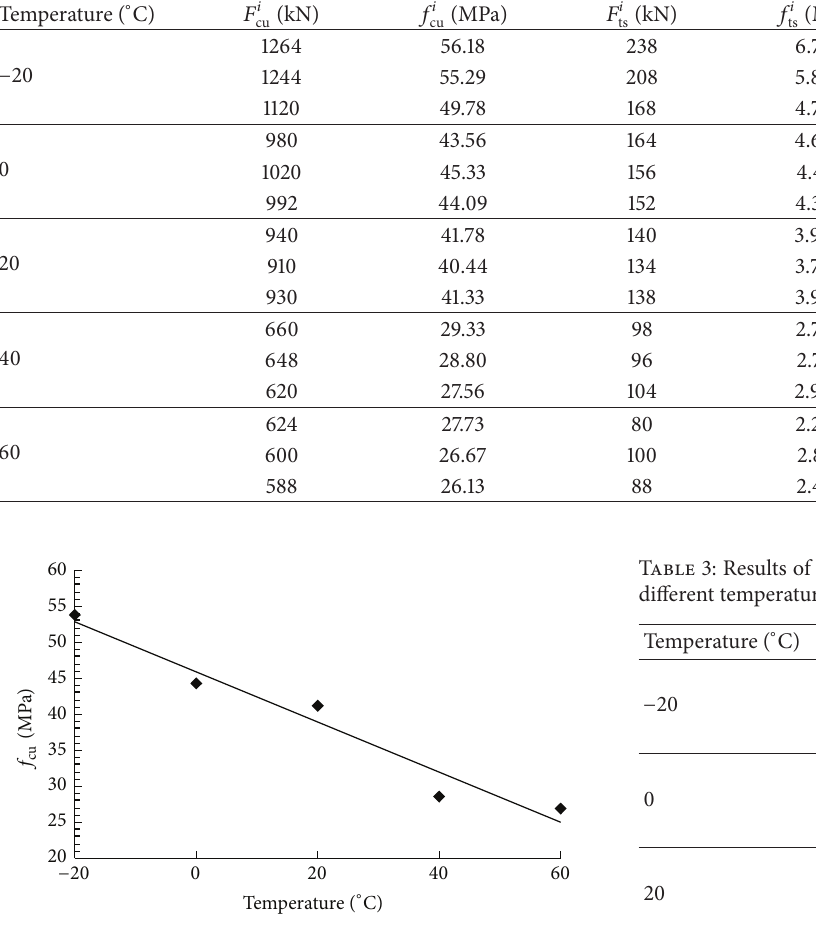
Figure 6: Temperature effect on cube compressive strength of concrete.